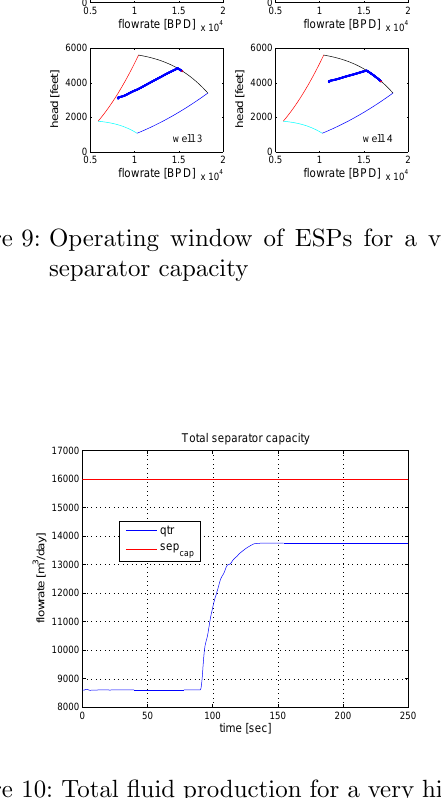
Figure 10: Total fluid production for a very high sepa- rator capacity